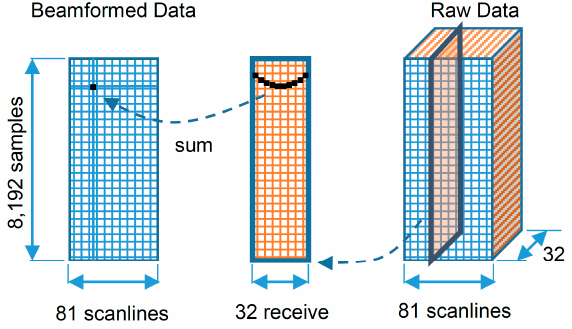
Figure 3. The data flowchart for beamforming.